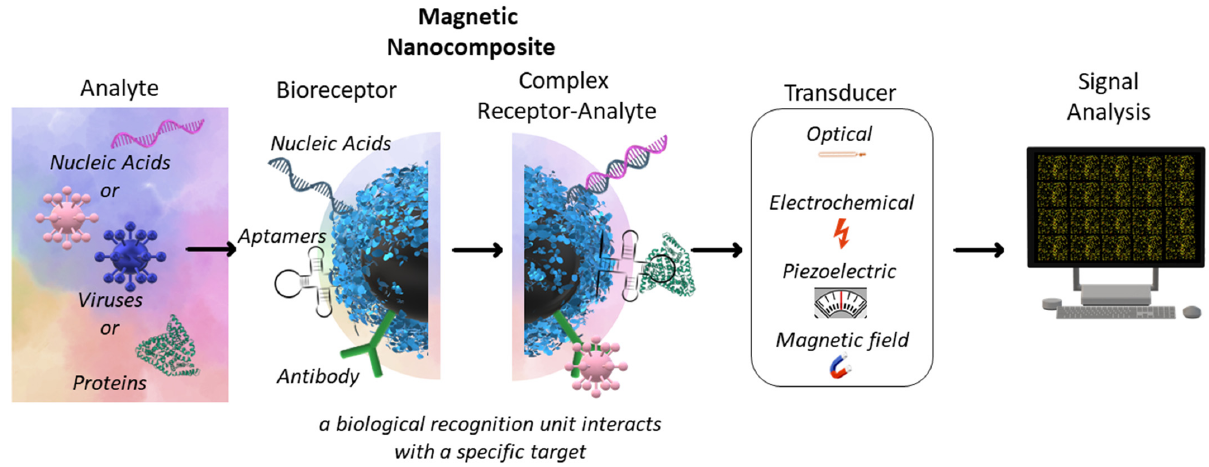
Figure 11. Basic principles of NA-based biosensors.